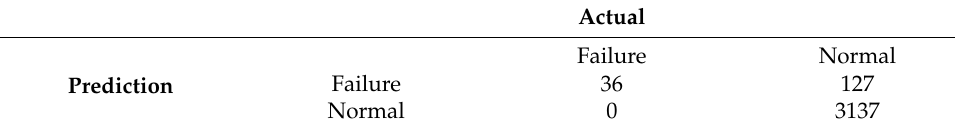
Table 13. Prediction results obtained for the OSF diagnosis using the confusion matrix.